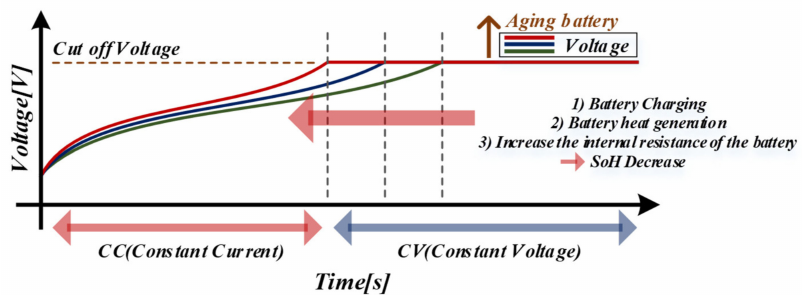
Figure 7. Voltage and SoH of a battery during